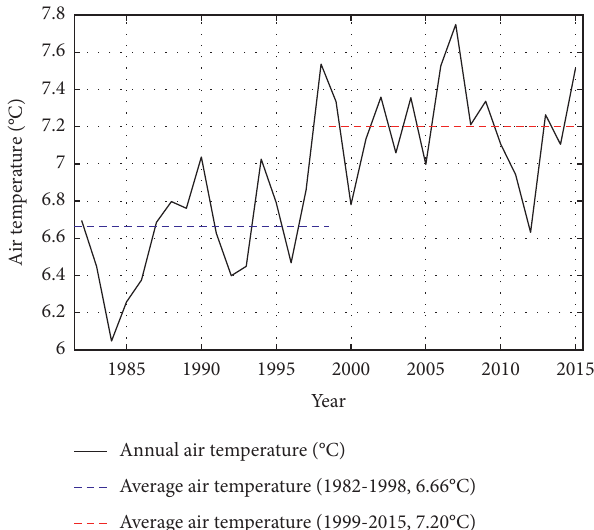
Figure 4: Mean annual air temperature from 1982 to 2015 in China.